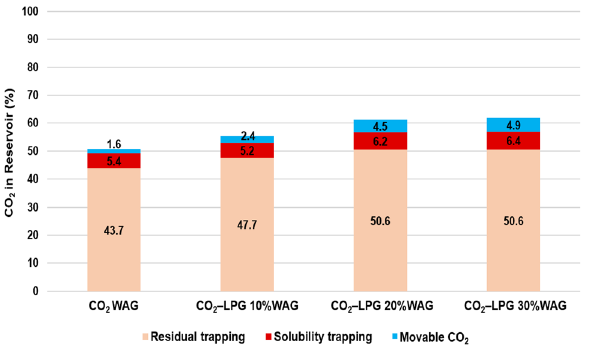
Figure 15. Remaining CO 2 in the reservoir according to trapping mechanism with various LPG concentrations.